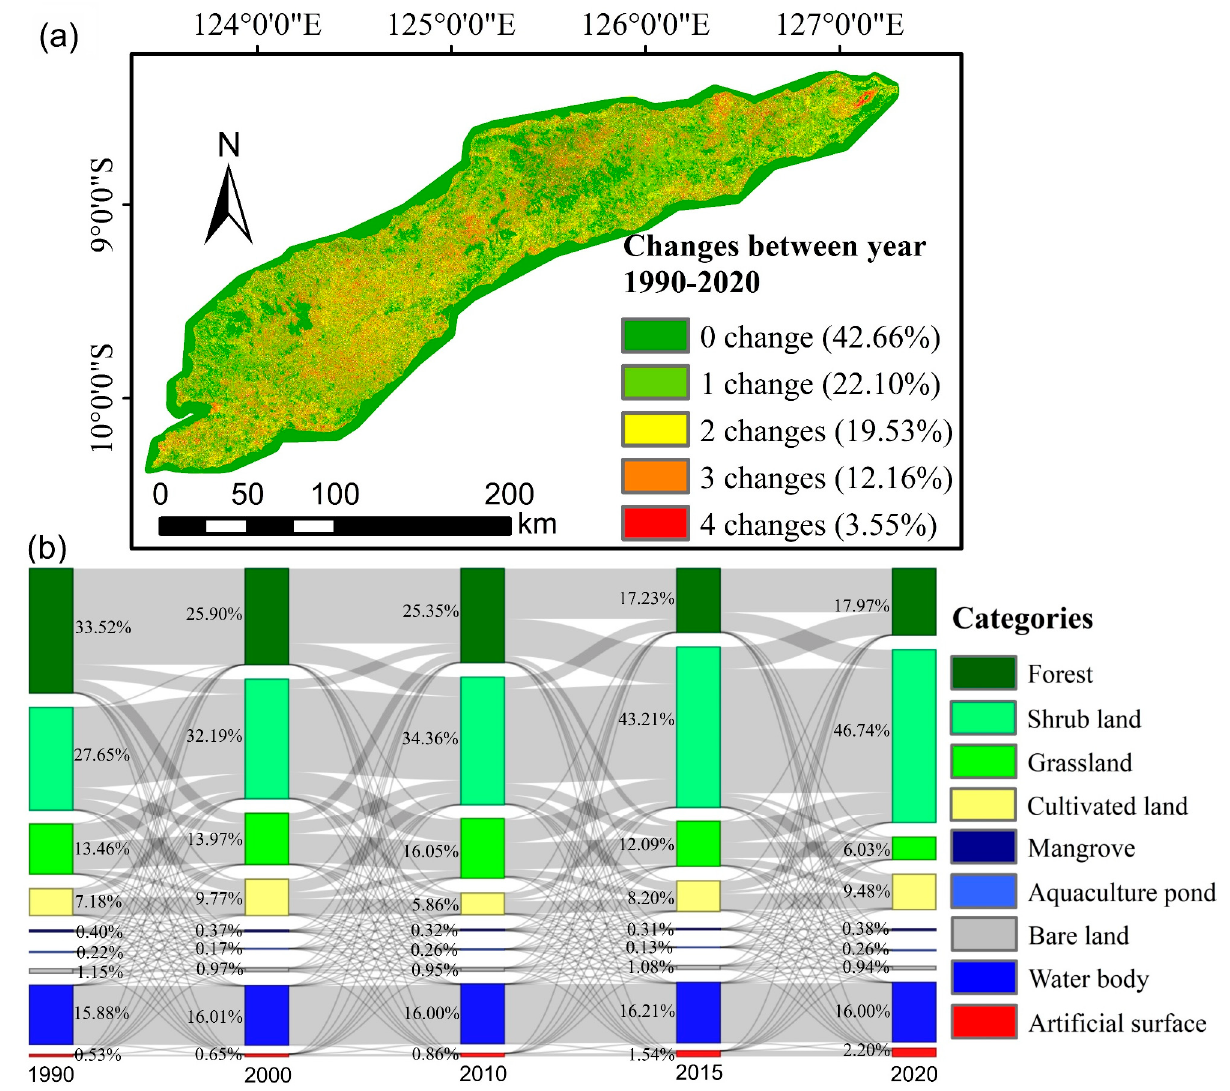
Figure 5. Changes in Timor from 1990 to 2020. ( a ) Land cover changes and ( b ) change flows between different land cover types.